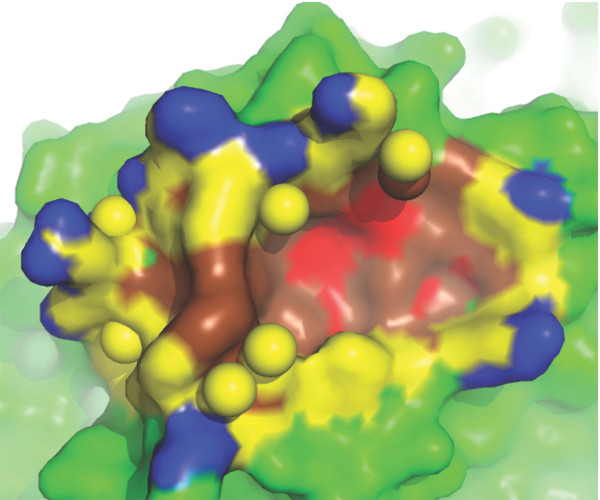
An example of interface containing a hub protein. The interface between a transducin with a cGMP phosophodiesterase ([PDB:1FQJ], resolution: 2.02 Å, wetness: 0.032, rWBL: 0.869). Only the transducin (in surfaces) and interfacial water molecules (in spheres) are shown. O0, O1, O2, O3 and non-interface are colored red, brown, yellow, blue and green, respectively.